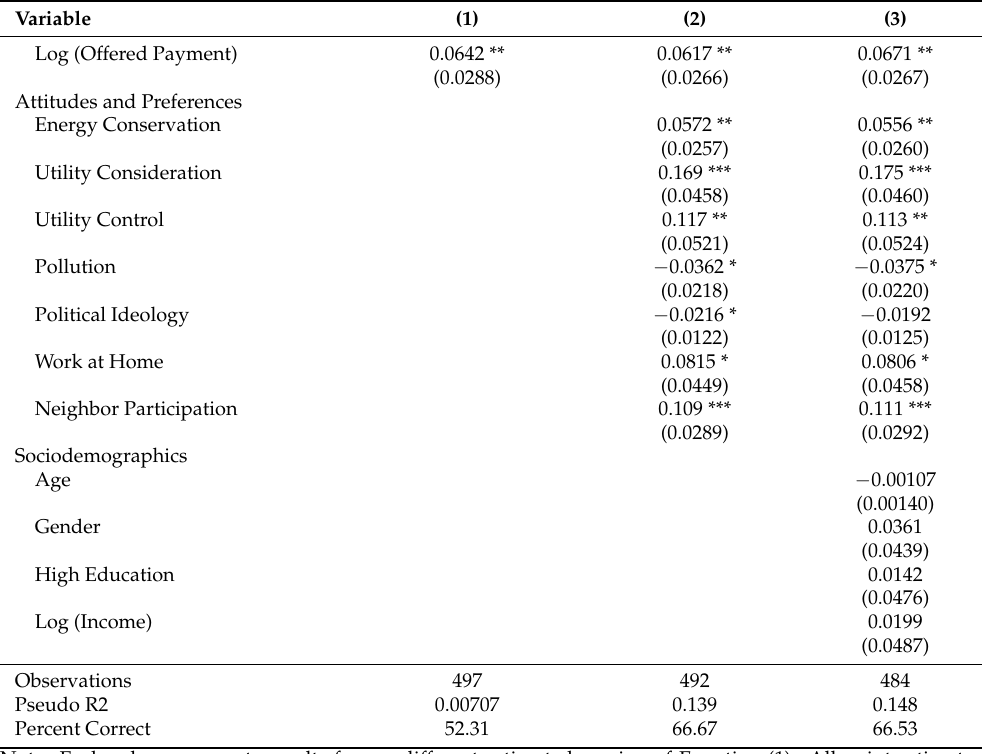
Table 3. Average marginal effects of participating in the smart thermostat